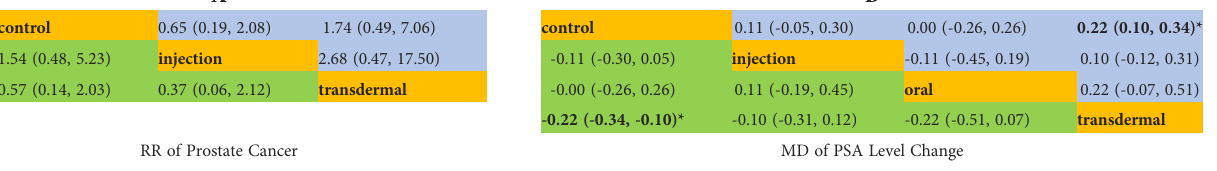
TABLE 4 Network Meta-analysis for RR of Prostate Cancer and MD of PSA Level Change.